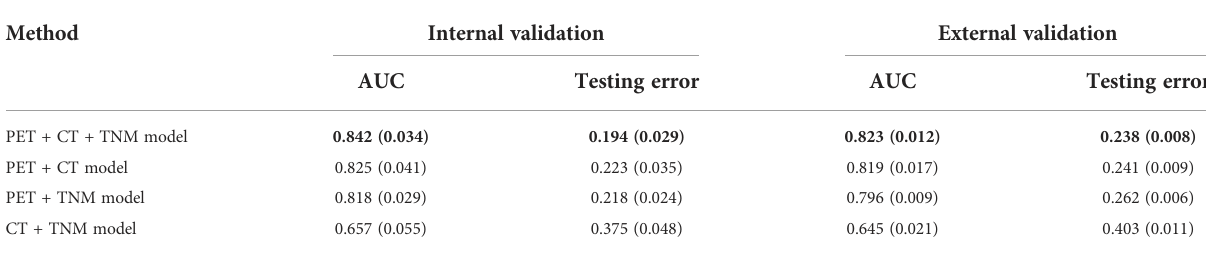
TABLE 2 Comparison among four DLR